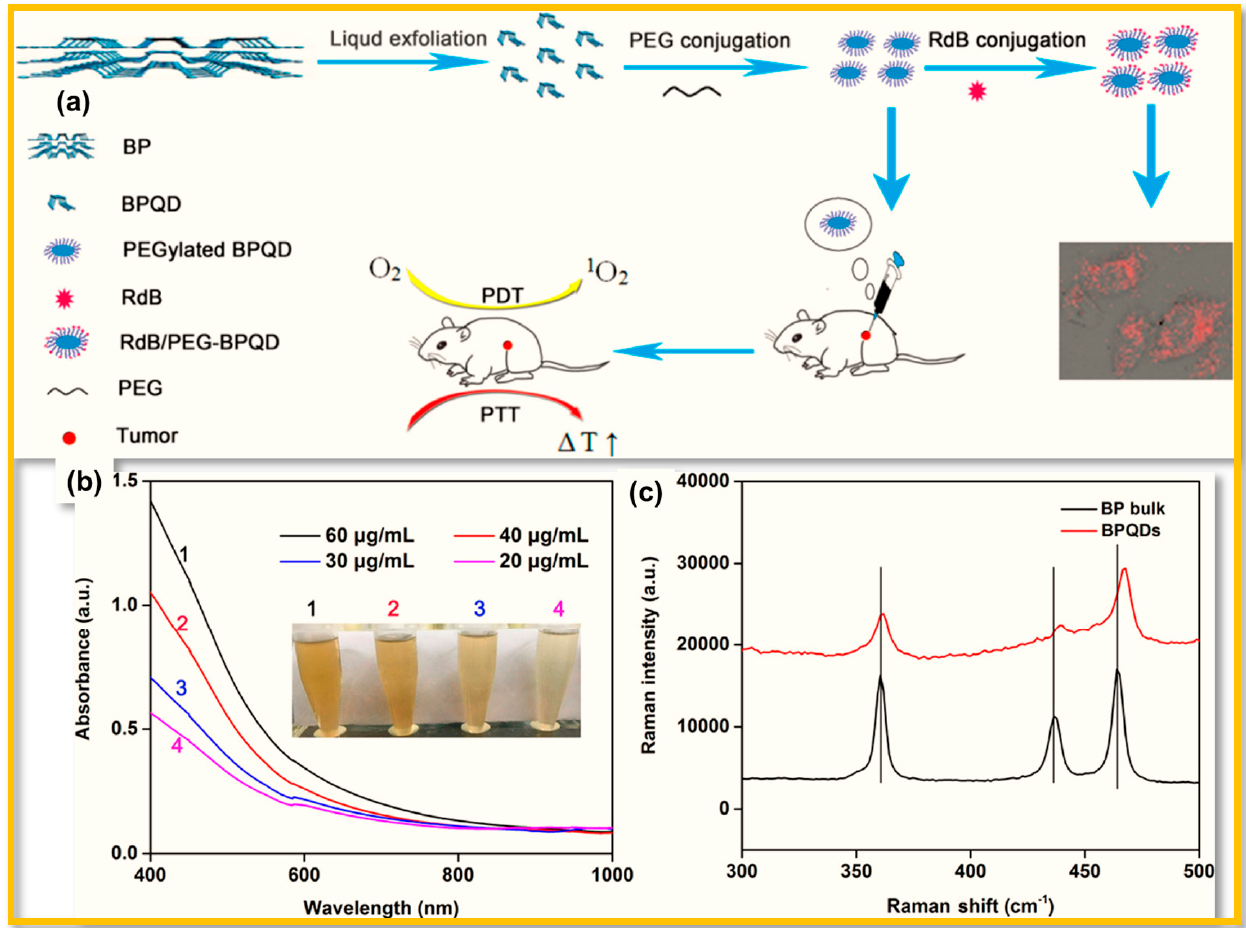
Figure 24. Schematic illustration of PEGylated BPQDs and the biomedical applications; ( a ) UV–vis– NIR absorbance spectra of PEGylated BPQDs at different concentrations. Inset: photos of PEGylated BPQDs solutions.( b ) UV–Vis spectra of BPQDs with different concentration of BP. ( c ) Raman spectra of BPQDs and bulk BP crystal. Reprinted (adapted) with permission from ACS Appl. Mater. Interfaces [141]. Copyright 2017 American Chemical Society.